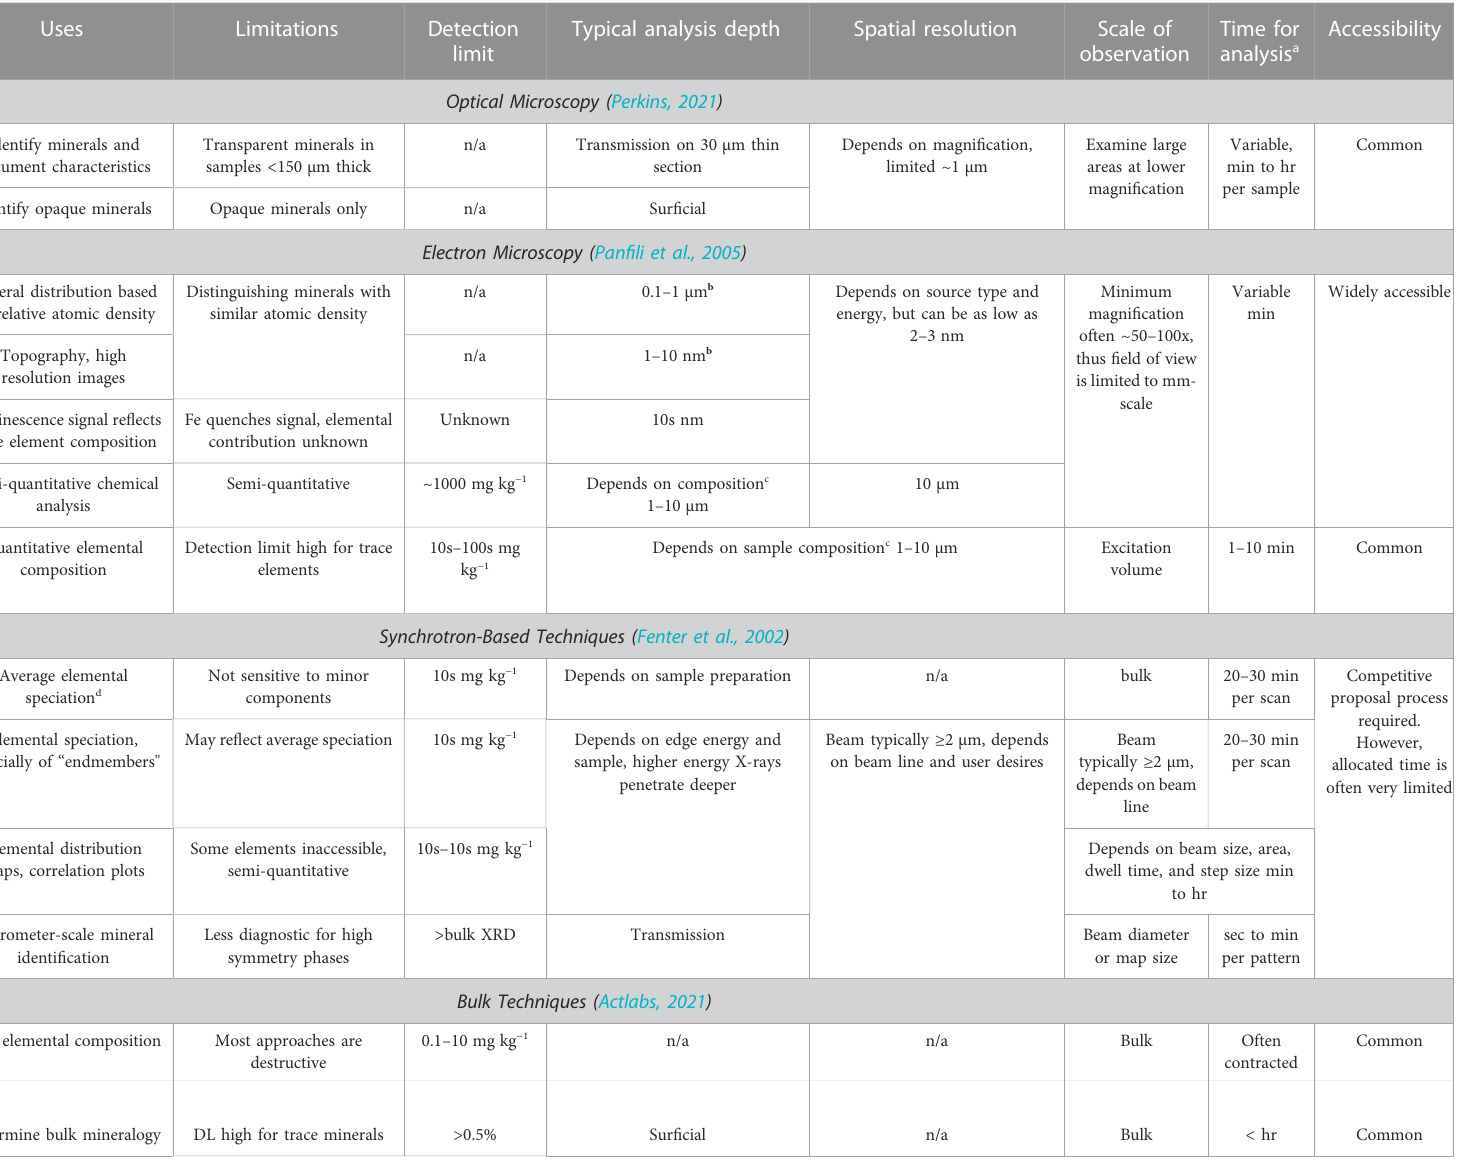
TABLE 1 A comparison of bulk and micro-focused